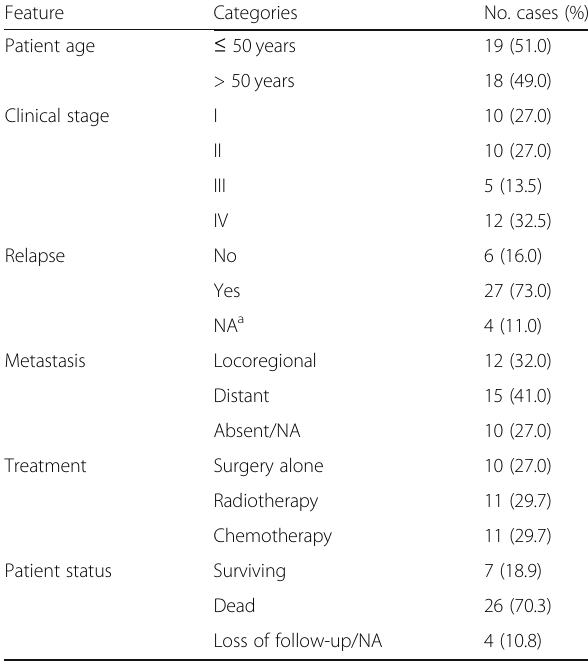
Table 2 Clinicopathological features of the patients with LMS (n=37)